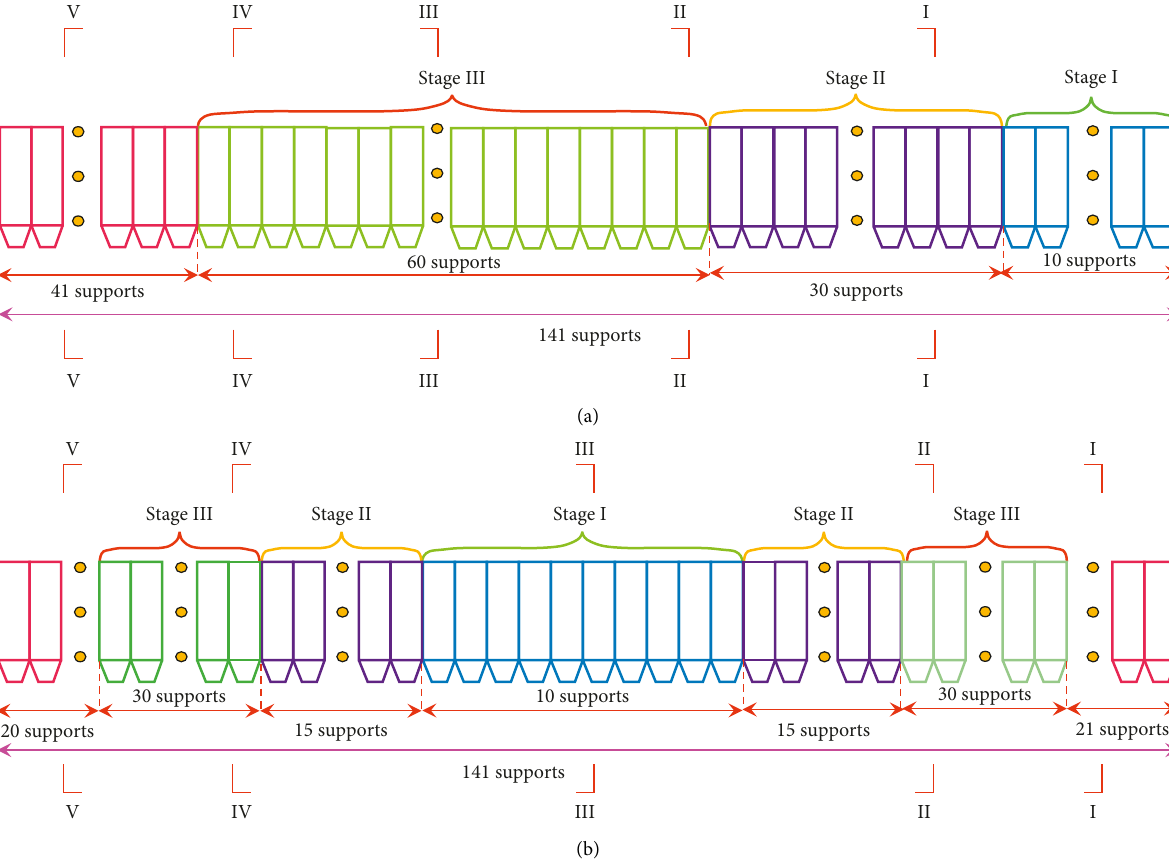
Figure 17: Schematic diagram of the two extraction processes. (a) Unidirectional extraction process. (b) Bidirectional extraction